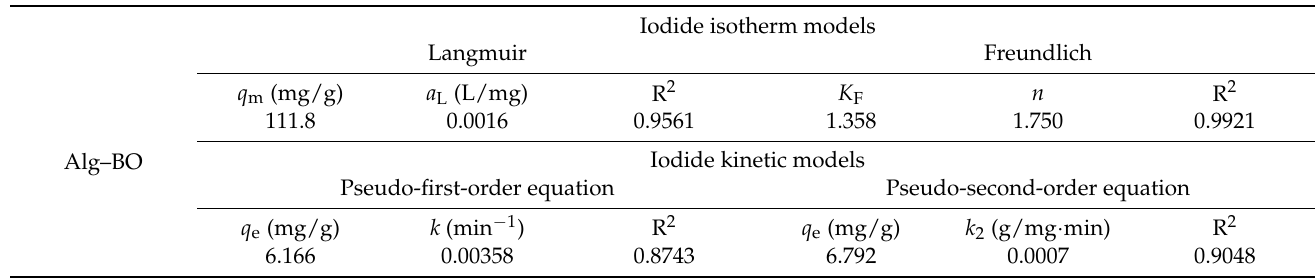
Table 1. Isotherm fitting and kinetic fitting parameters of iodide adsorption by Alg–BO.